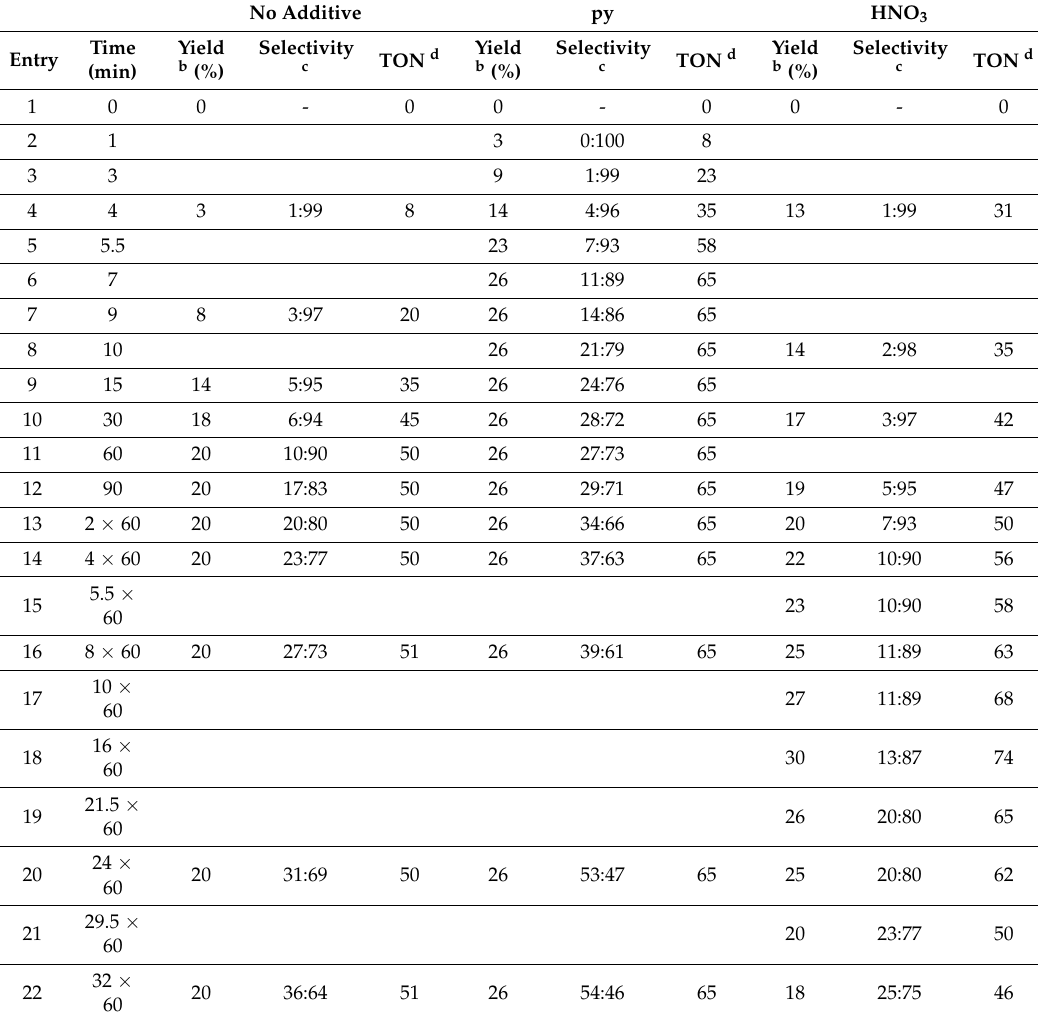
a Reaction conditions: cyclooctane (0.25 M), complex 3 (10 − 3 M), additive (0.072 M), H 2 O 2 (1.2 M) in acetonitrile at 60 ◦ C; total volume of reaction mixture is 10 mL. b Amounts of cyclooctanone and cyclooctanol were determined after reduction of the aliquots with solid PPh 3 (for this method, see references [61–65]). c Cyclooctanone/cyclooctanol ratio. d Turnover number of the catalyst (sum of moles of all products per mole of 3